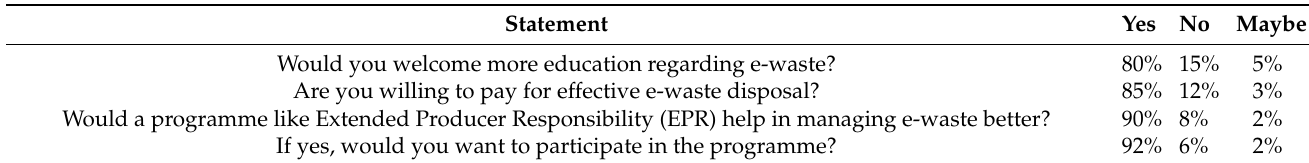
Table 5. Respondents’ willingness to participate in e-waste